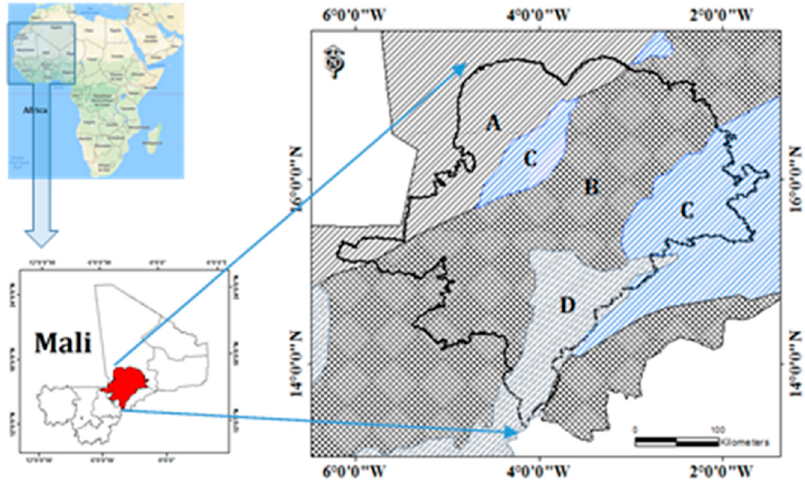
Figure 1. Presentation of the study area; A : Continental terminal/Intercalary; B : Continental terminal/quaternary; C : Precambrian folded; D : Precambrian tabular.